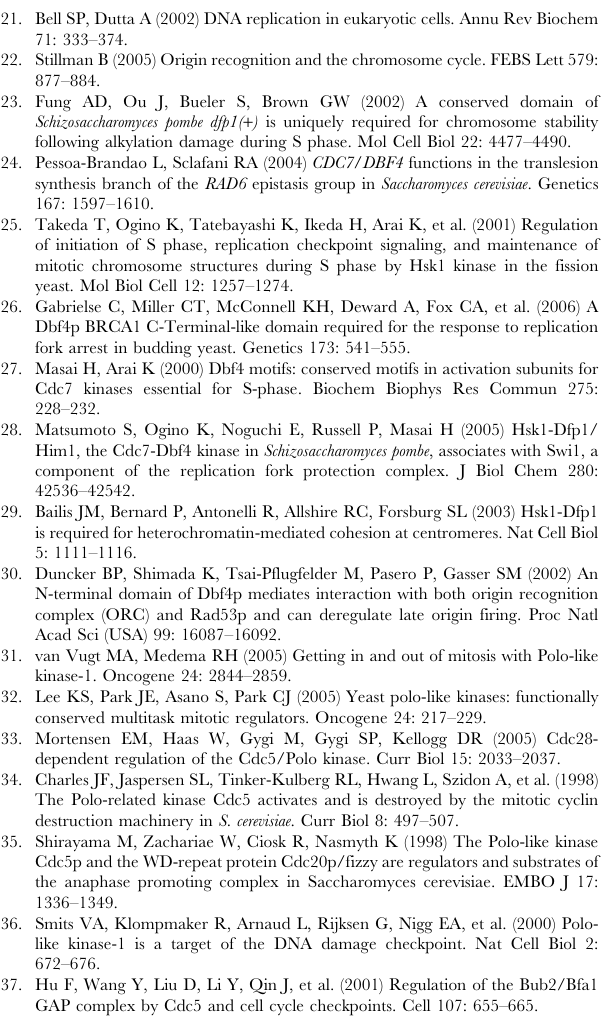
Table S2 Plasmids used in this